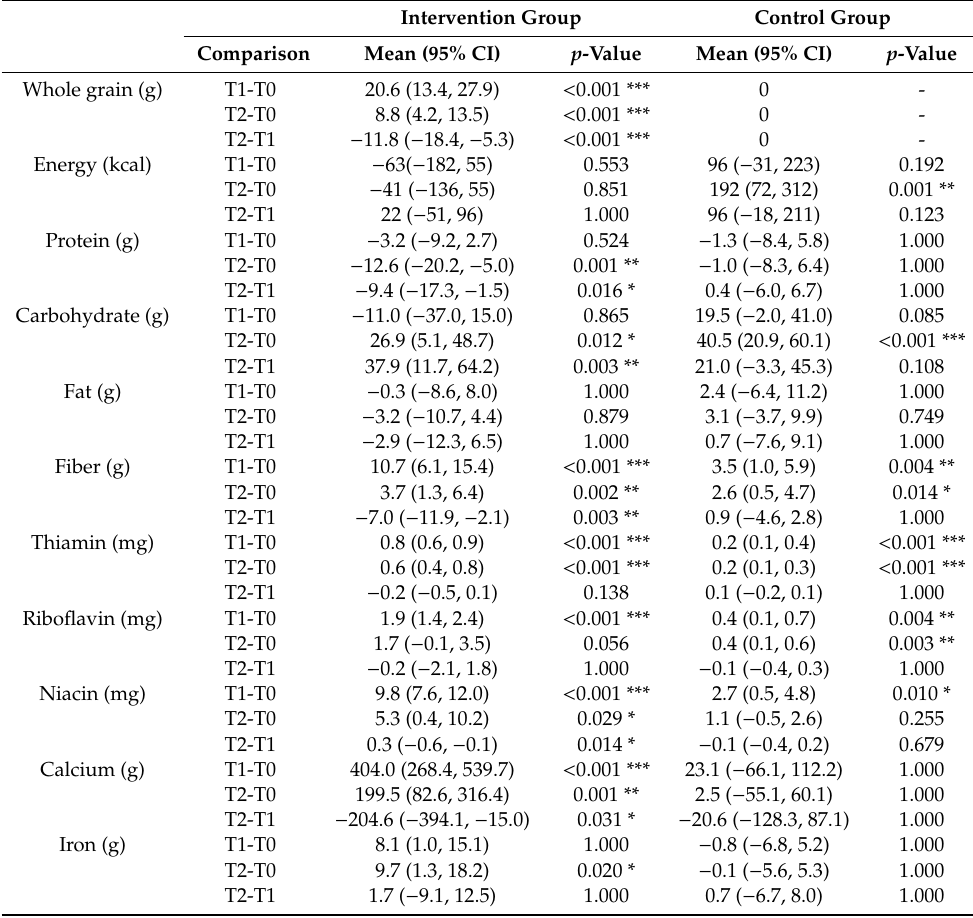
Table 2. Changes in whole grain and nutrient intakes within group ( n = 59).